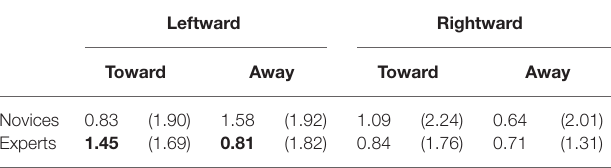
TABLE 2 | Response error rates (and standard deviations) for each group in each test frame position in the leftward direction.